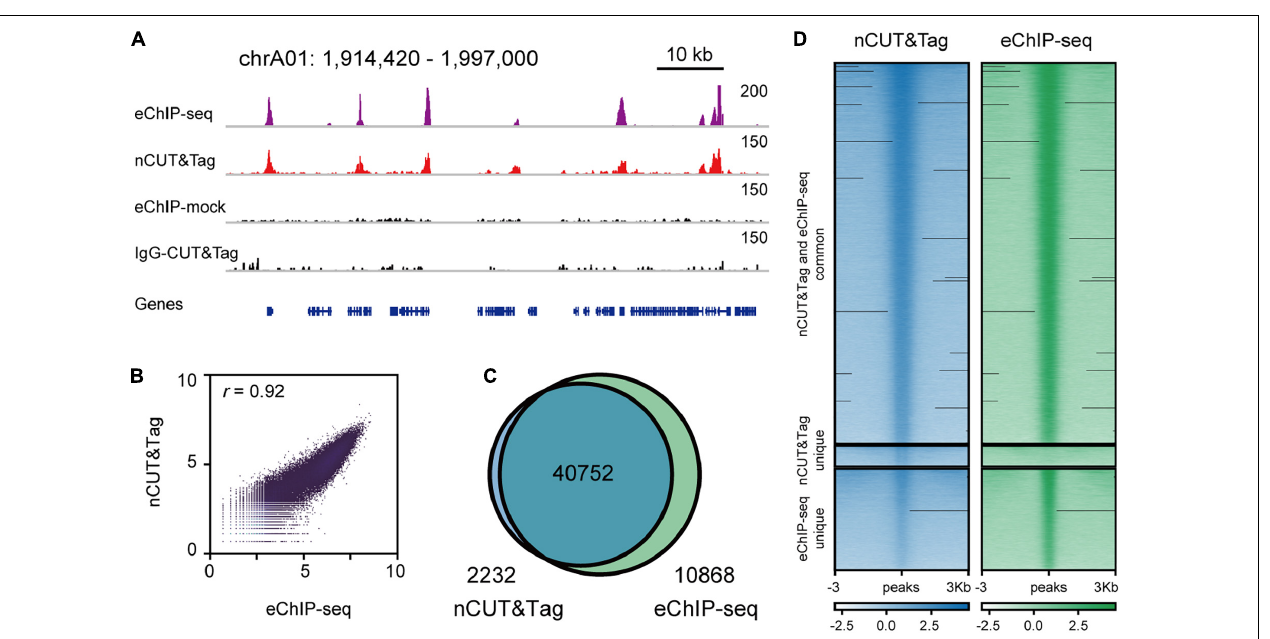
( Figure 4A and Supplementary Table 1 ). Among the 26,015 peaks identified by the two nCUT&Tag replicates, about 80% (20,646 peaks) were also detected by the eChIP-seq; 5369 peaks were detected by the fresh nCUT&Tag only, while 2244 were